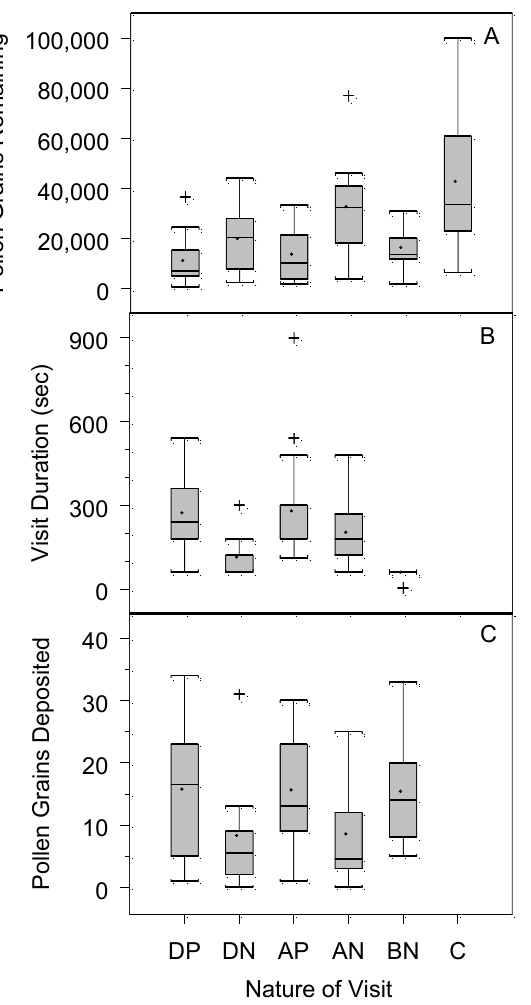
F IGURE 1. Box plots of results of single bee-visits to previously unvisited Iliamna bakeri flowers: A) number of pollen grains remaining; B) the duration of single flower-visits; C) the number of pollen grains deposited on stigmas. Shown are means (circles), maximum and minimum values, 25 th and 75 th percentiles, and outliers (+). Abbreviations: D (Diadasia – specialist), A (Agapostemon – generalist), B (Bombus – generalist), P (pollen- collectors), N (nectar-collectors), C (Control). Sample sizes: DP (26), DN (12), AP (20), AN (10), BN (11), C